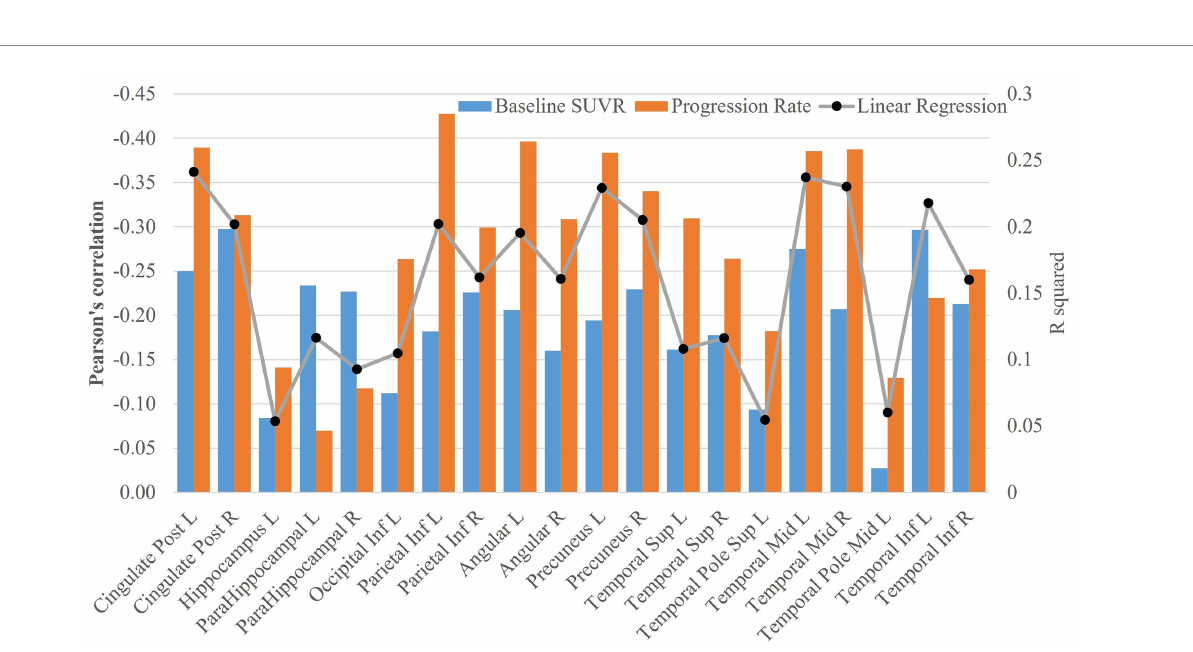
FIGURE 4 Association analysis of FDG-PET data with cognitive decline rate. The bar plots of Pearson’s correlations between cognitive decline rate and SUVR at baseline or FDG-PET progression rate were shown in the figure. The adjusted R 2 values (black dots) from the linear regression model Cognitive decline rate ~ 1 + baseline SUVR + FDG-PET progression rate were also plotted in the